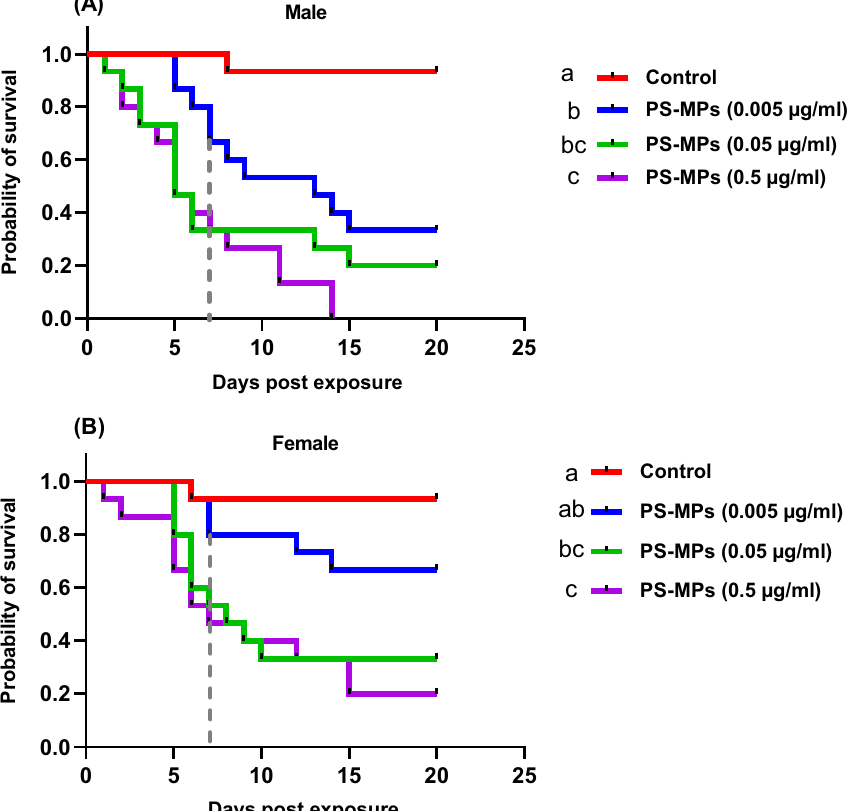
Figure 3. Kaplan–Meier survival curves showing effects of different concentrations polystyrene microplastics (PS-MPs) on survival of newly emerged male ( A ) and female ( B ) adult D. melanogaster flies. Flies were exposed for 7 days to a control or food media spiked with 0.005 or 0.05 or 0. 5 µg/ml of PS-MPs and then transferred to normal cultural media every two days. Different lowercase letters indicate statistical differences between treatments after Bonferroni correction (log-rank (Mantel cox) paired test, p < 0.008). Vertical dashed line indicates the end of PS-MPs exposure time.